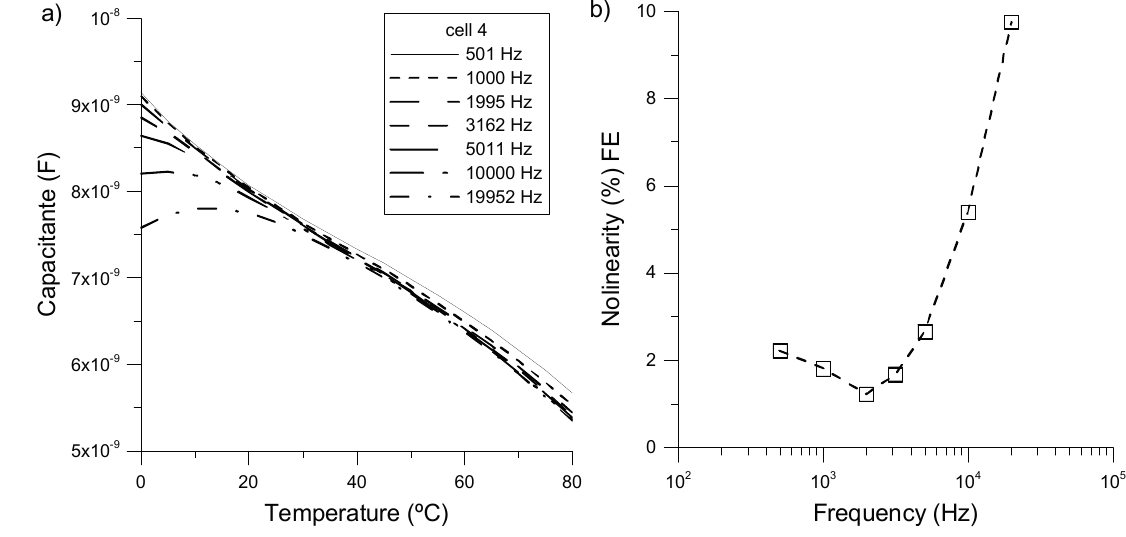
Figure 7. ( a ) Temperature dependence of the capacitance of cell 4 at various frequencies; ( b ) Non-linearity of cell 4 as a function of